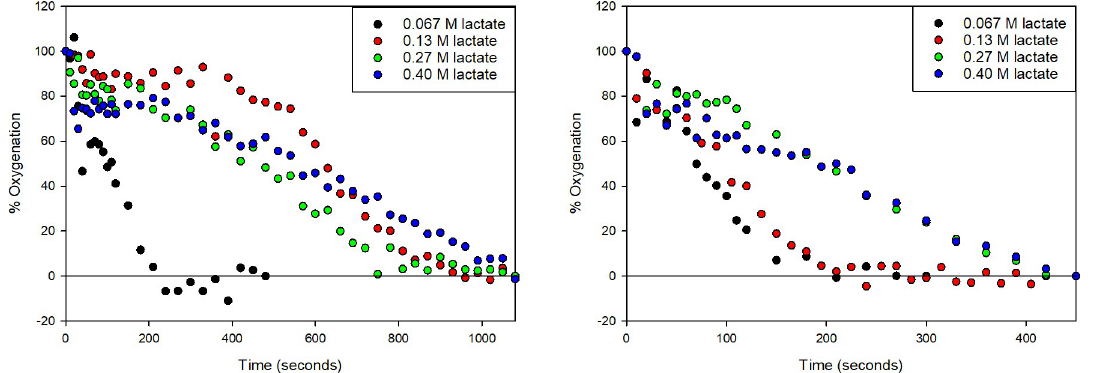
Fig 2. A. OxyHb consumption over time using 4% vol Oxyrase with different lactate concentrations. Hb is treated with 4% vol Oxyrase and lactate and the % oxyHb is calculated using the Tsao method for deoxyHb. B. OxyHb consumption over time using 6% vol Oxyrase with different lactate concentrations. Hb is treated with 6% vol Oxyrase and lactate and the % oxyHb is calculated using the Tsao method for deoxyHb.